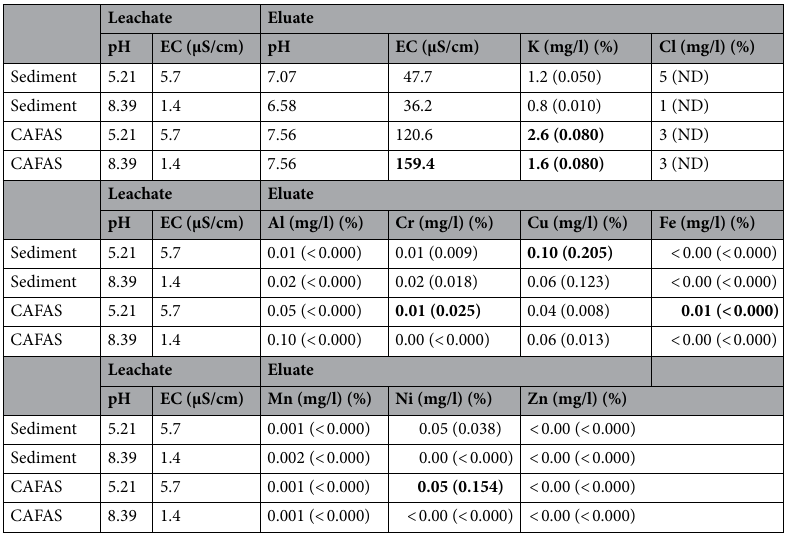
Table 3. Characteristics of water leachate and eluates with the percentage of compounds leached from cave sediment and CAFAS. In bold – the highest value; ND no data.